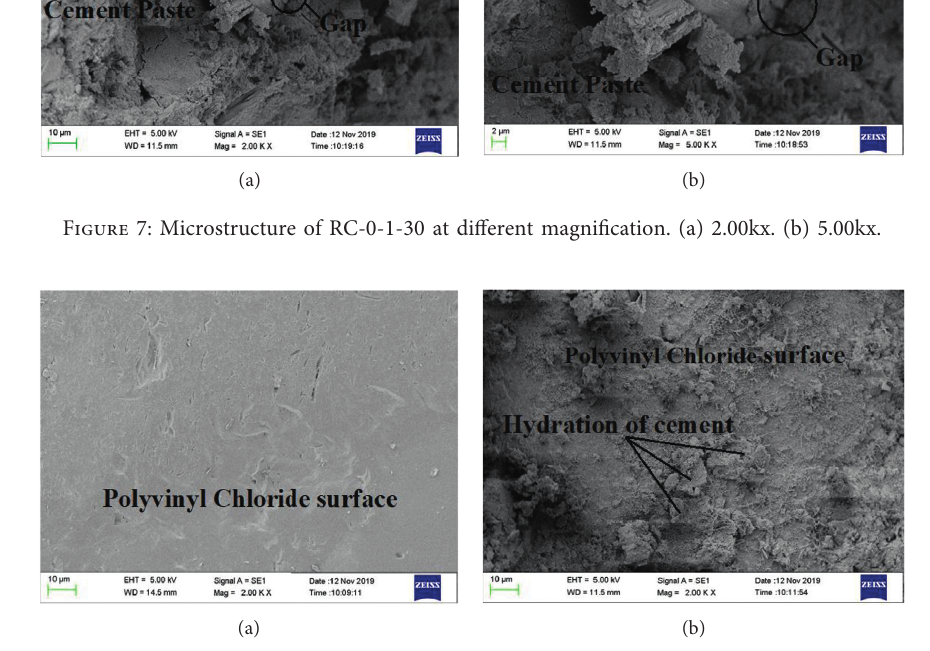
Figure 8: Microstructure of PVC aggregate surface before and after modification in concrete. (a) Unmodified surface. (b) Modified surface.